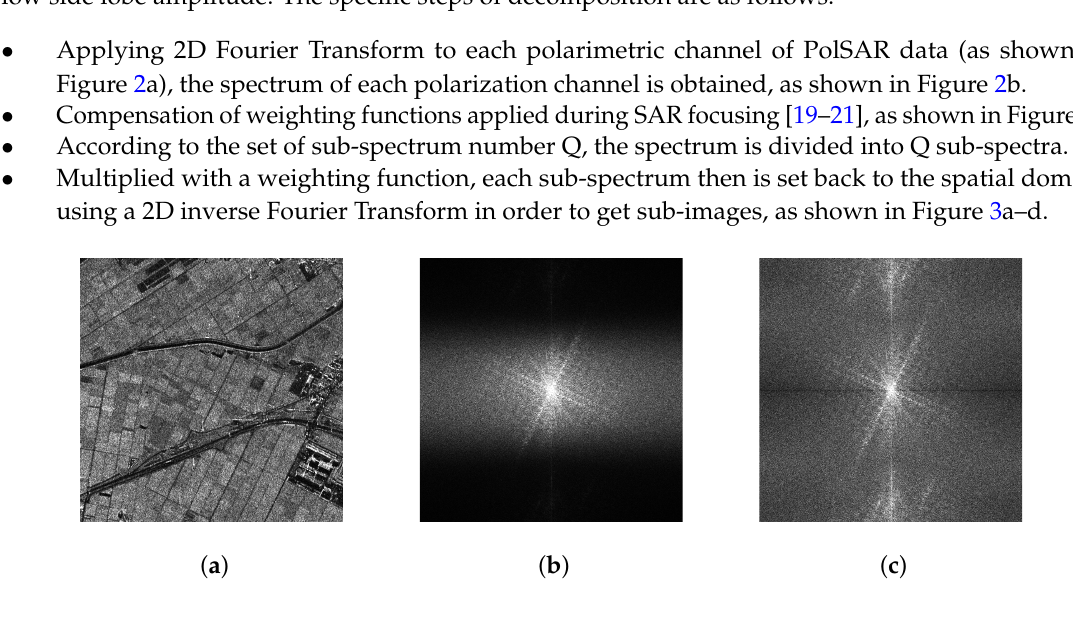
Figure 2. An example of the TF decomposition process. ( a ) the data of the HH channel; ( b ) the spectrum of the HH channel; and ( c ) the spectrum after compensation.